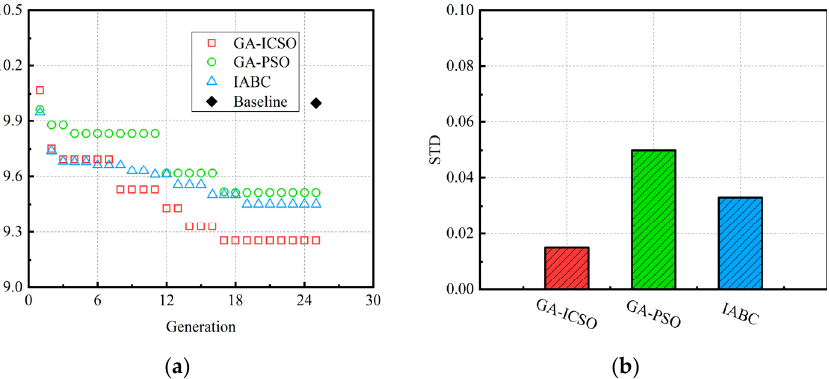
Figure 14. Optimization history of GA-ICSO, GA-PSO and IABC for 75% load: ( a ) Objective function convergence; ( b ) STD.